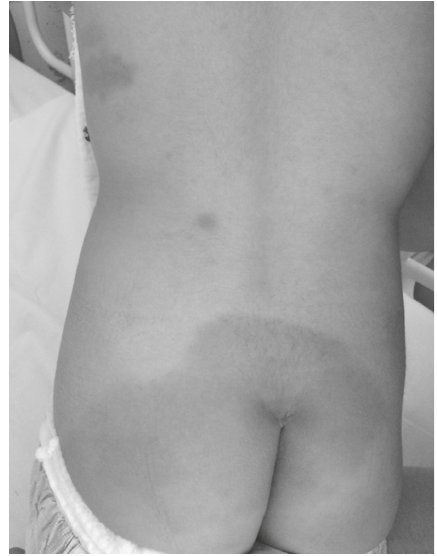
Figure 4: Mongolian spot.